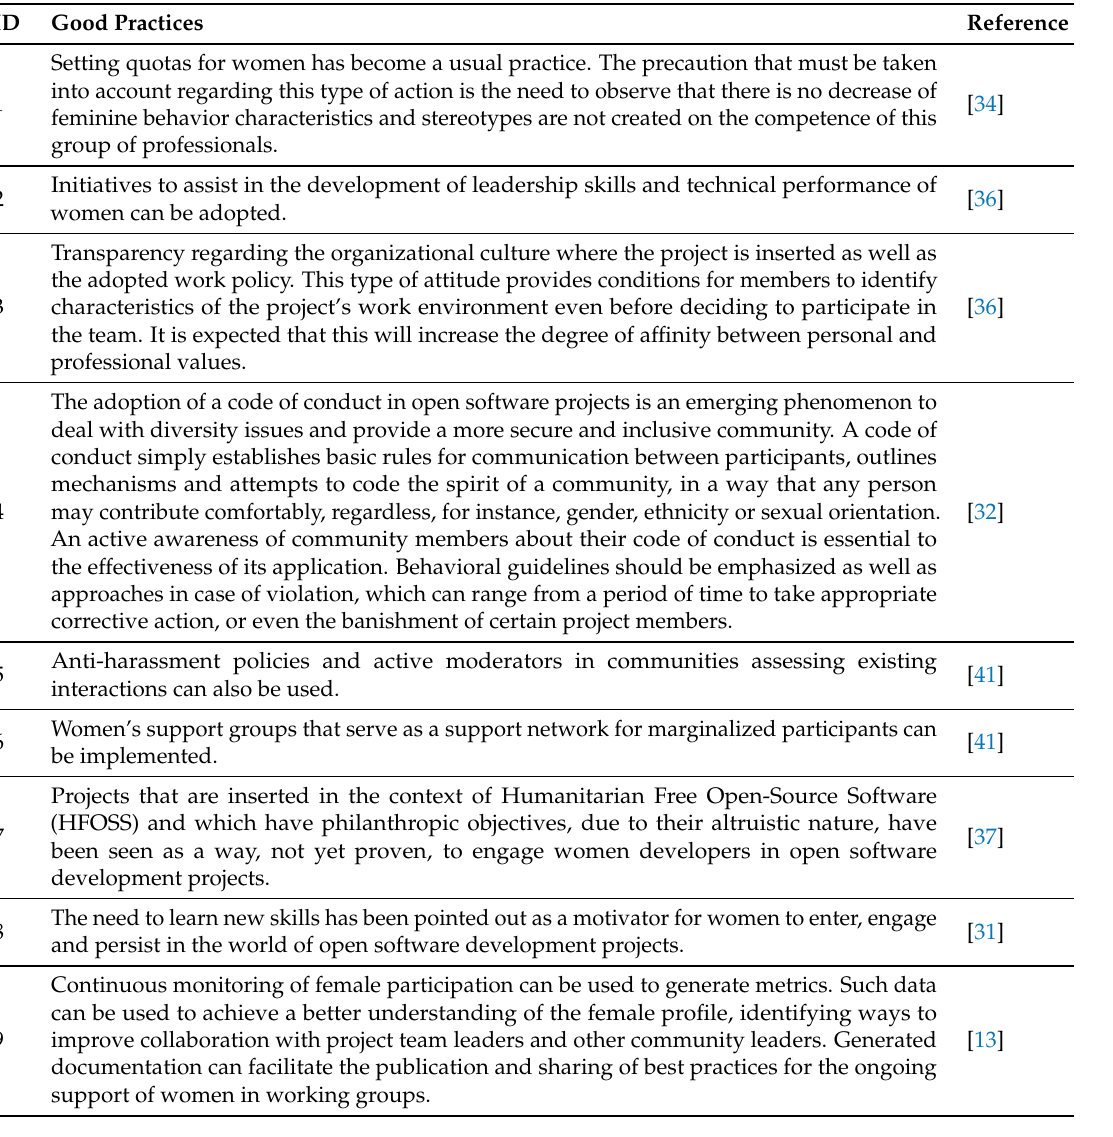
Table 3. Good practices